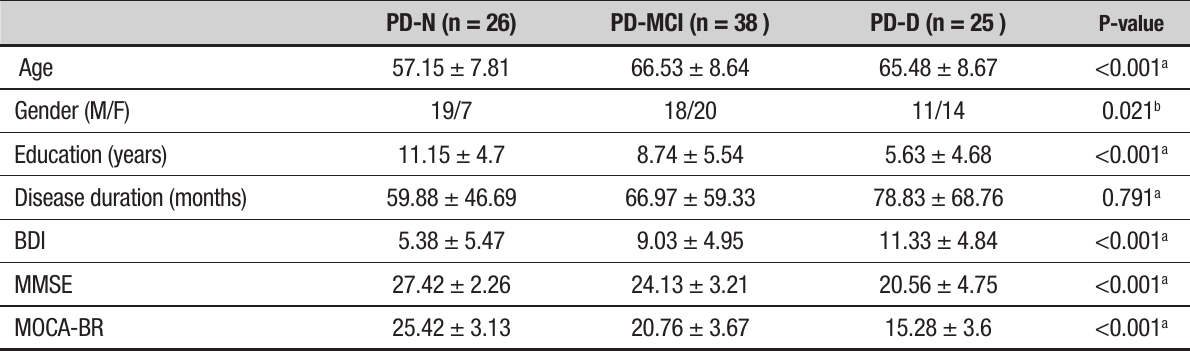
Table 1. Clinical and demographic characteristics of Parkinson’s disease